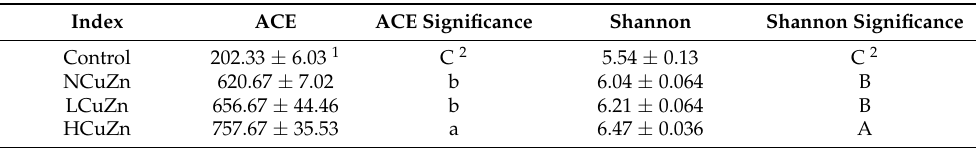
Table 2. Bacterial community richness and diversity indices in soil